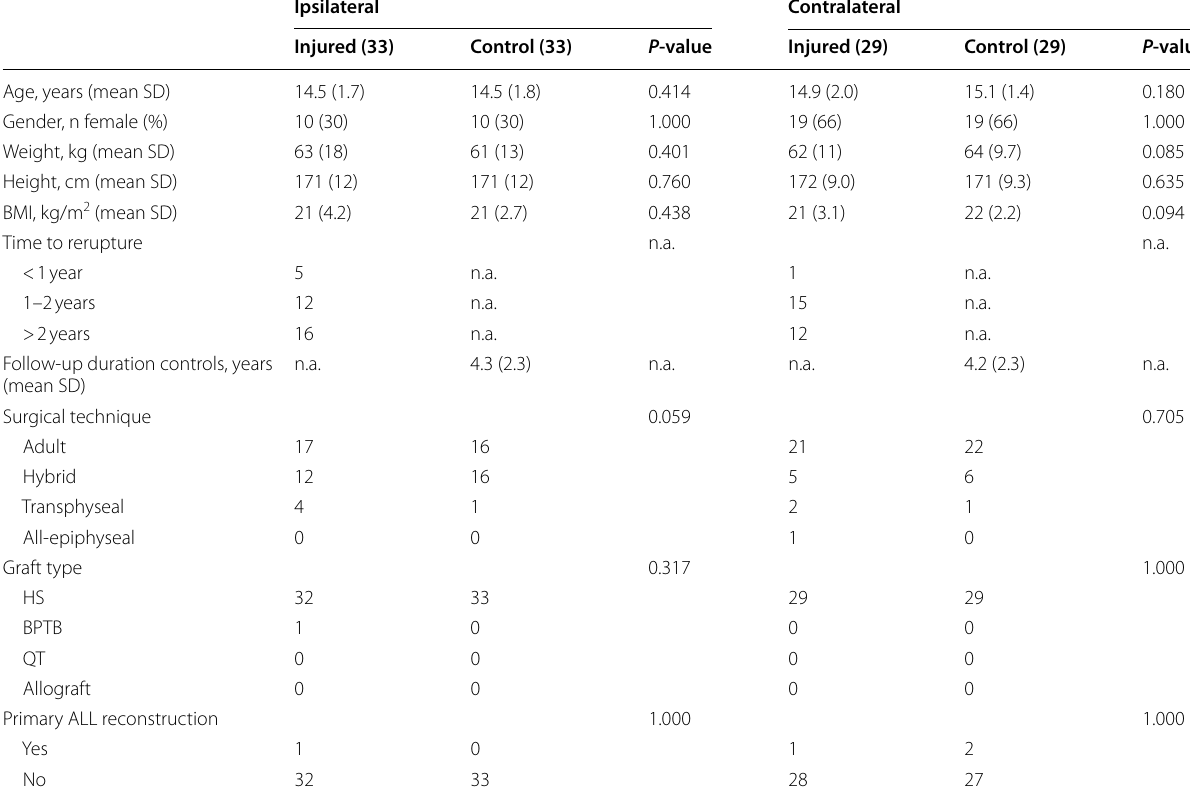
Table 3 Demographic characteristics ipsi- and contralateral